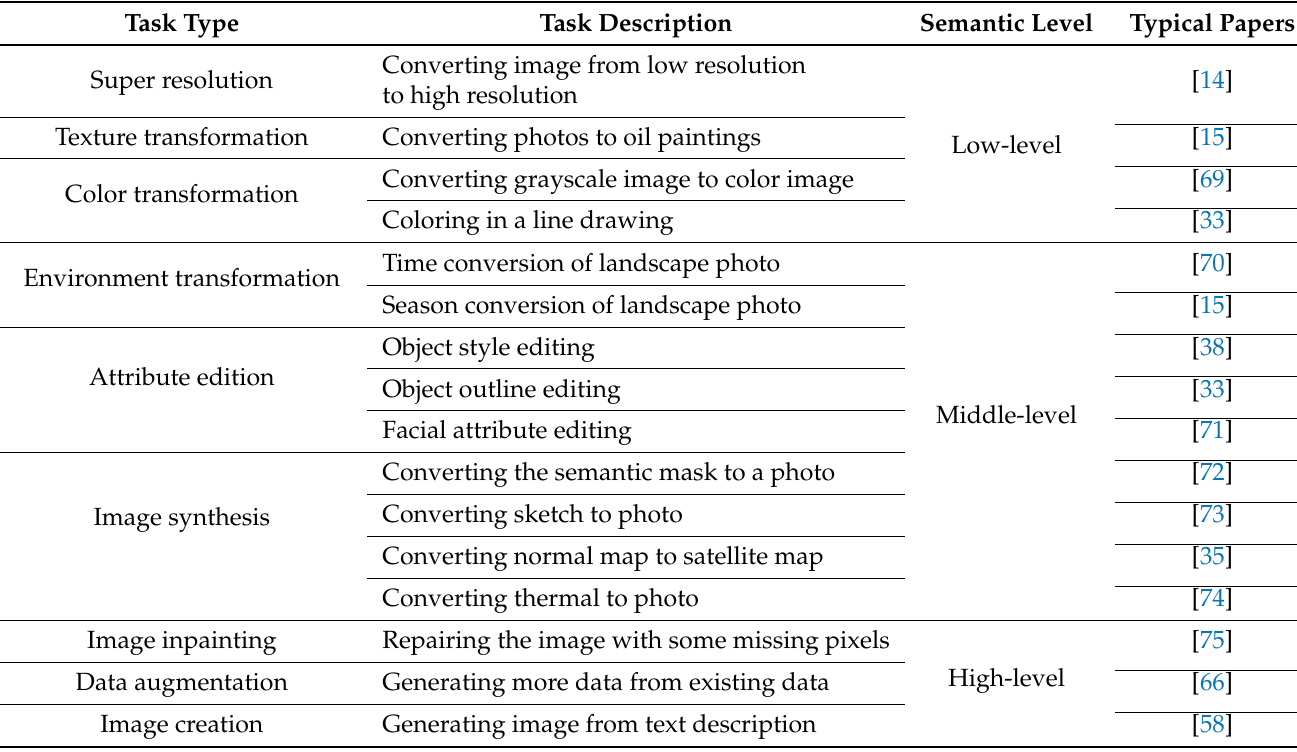
Table 4. The classification of tasks involving